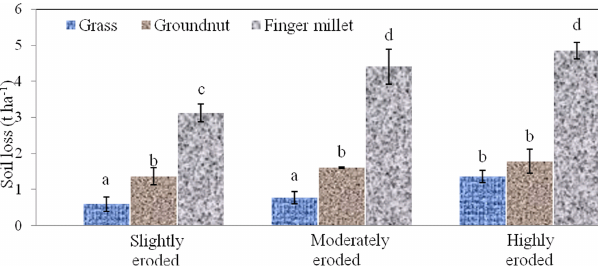
Figure 3. Impact of grasses in reducing soil loss in lateritic